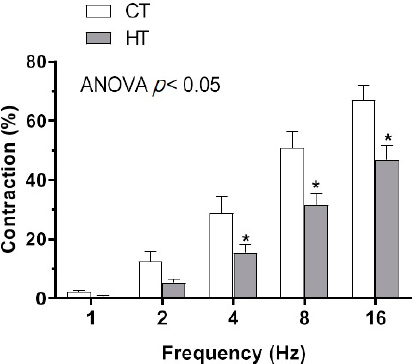
Figure 1. Electrical field stimulation (EFS)-induced vasoconstriction in mesenteric segments from control (CT) and hyperthyroidic (HT) Wistar rats. Results (mean ± S.E.M.) are expressed as a percentage of the previous tone elicited by KCl. n = 5–6 segments from different rats in each experimental group. * p < 0.05 CT vs. HT at each frequency (Bonferroni post hoc test). The fact that preincubation with the nerve impulse propagation blocker TTX abol- ished EFS-induced contraction in segments from both experimental groups (Table 2) con- firmed the neural origin of this EFS-induced vasoconstriction.